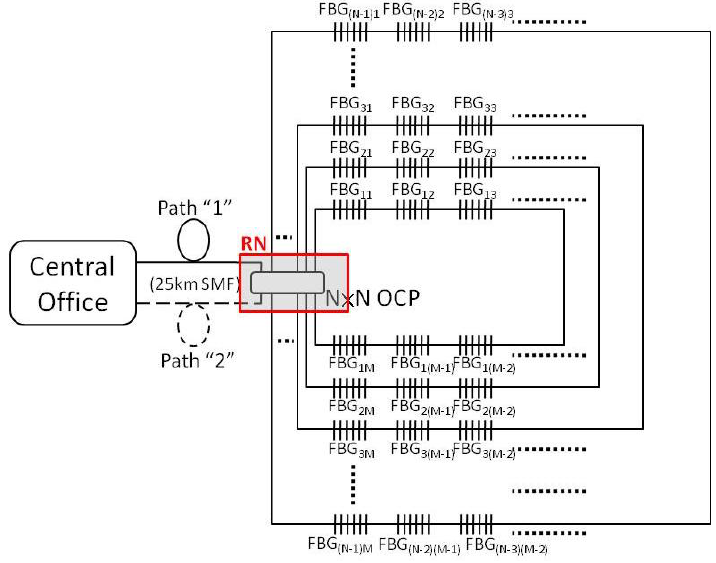
Figure 1. Proposed long distance FBG sensor system in passive multi-ring architecture.